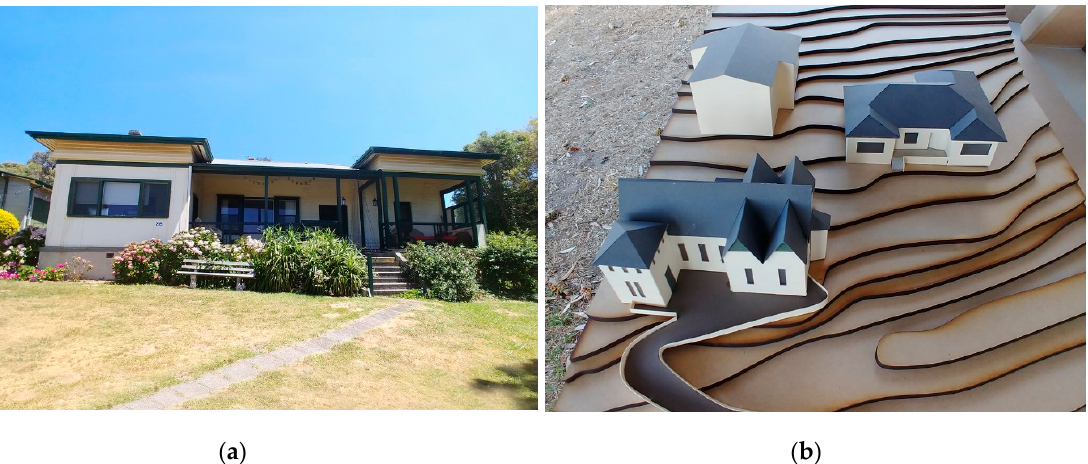
Figure 6. Photos of the Uniting Church’s Mountjoy Parade, Lorne, properties. ( a ) The Manse. Photo source: authors. ( b ) Model of the existing site. Photo source: authors; model image reproduced with the consent of the director of studio a2, architect Stewart Seaton.